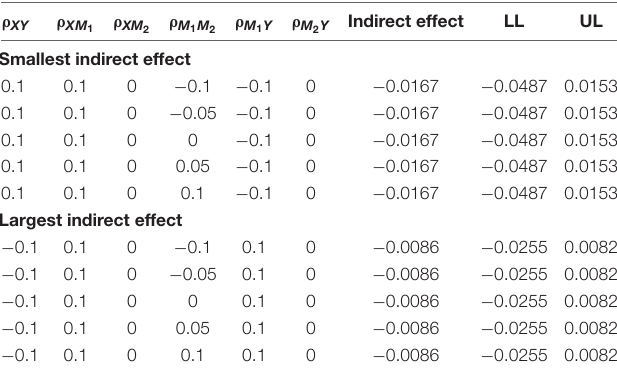
TABLE 1 | A sample of sensitivity analysis results for indirect effect through intercept for zero to small confounder correlation.